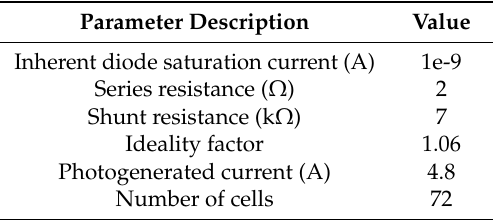
Table 2. PV (photovoltaic) panel model: simulation parameters at standard